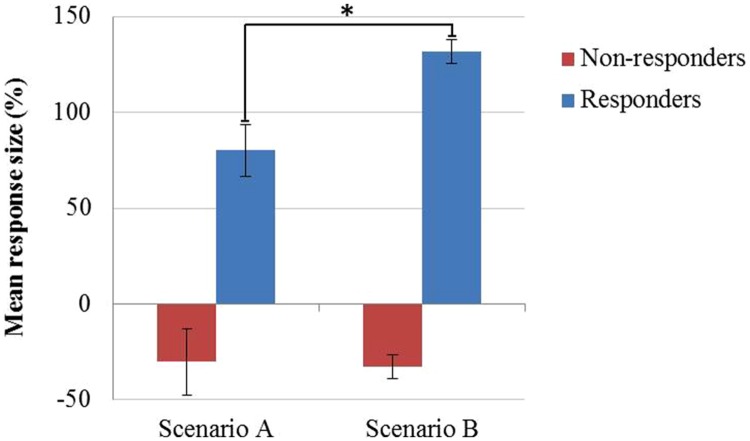
Performance style and response size in placebo responders and non-responders. Bars represent mean ± SE of % change in CPT threshold of 60 subjects in scenario A: 53 non-responders vs. 7 responders and 62 subjects in scenario B: 51 non-responders and 11 responders. Two-way ANOVA by performance style and responsiveness revealed significant effects of doctor’s performance (F = 4.30; p = 0.040; η2 = 0.035) and responsiveness (F = 134.71; p < 0.001) as well as a significant interaction term (F = 5.21; p = 0.024). ∗p = 0.020, Fisher’s least significant difference post hoc test.